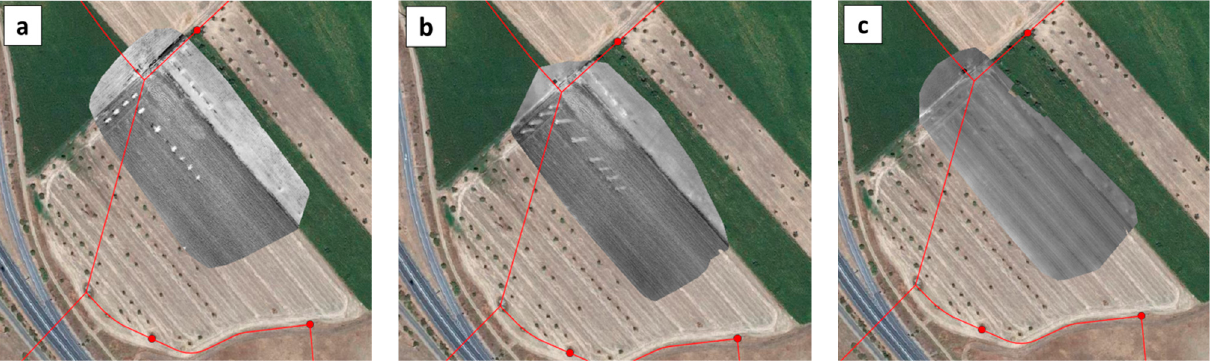
Figure 18. WI images obtained on 10 September 2019 with the UAV, of a field in the Monte Novo area having shown a “water anomaly” in the MAV images recorded during the April and September 2019 campaigns (Figure 17). The WI anomaly is delineated with a yellow ellipse in Figure 17b. WI images were obtained at ( a ) 16:01 h, ( b ) 18:11 h, and ( c ) 20:00 h, just after sunset.